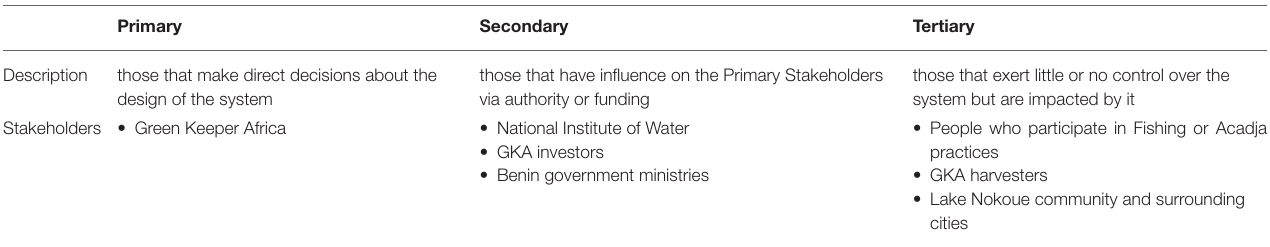
TABLE 1 | Summary of stakeholders in the system.